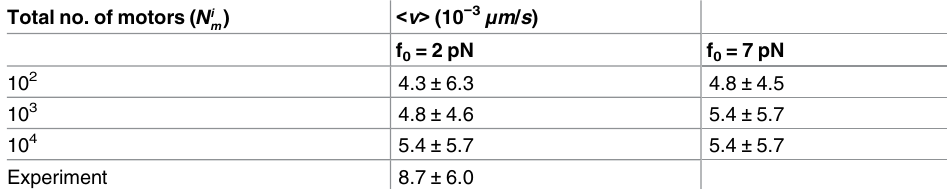
Table 4. MTOC velocity in a motor gradient. The mean instantaneous velocity ( < v > ± s.d.) with increasing motor density was calculated from 20 min simulation time and compared to experiment.